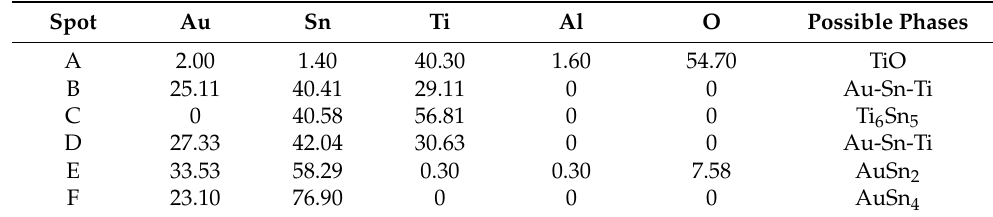
Table 3. EDS chemical analysis of the regions marked in Figure 4a,b